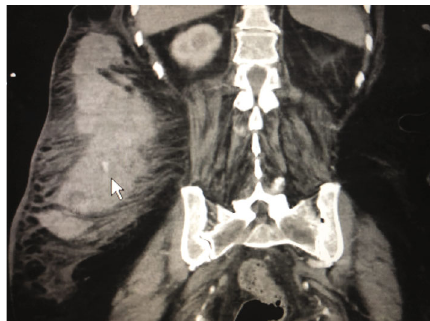
Figure 6: Digital subtraction angiography screenshot for the second patient after embolization was completed; the white arrow points towards the coiled blood